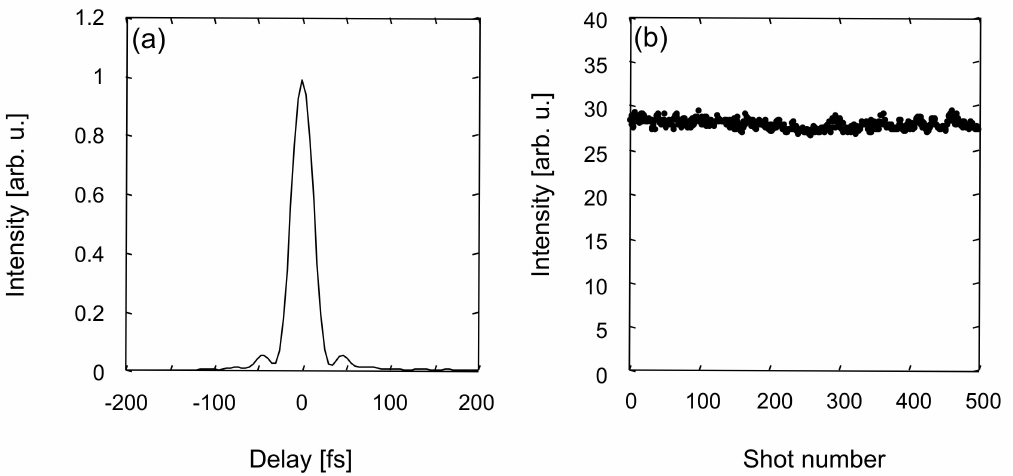
Figure 7. ( a ) Measured recompressed pulse profile. ( b ) Measured pulse width (FWHM) versus shot